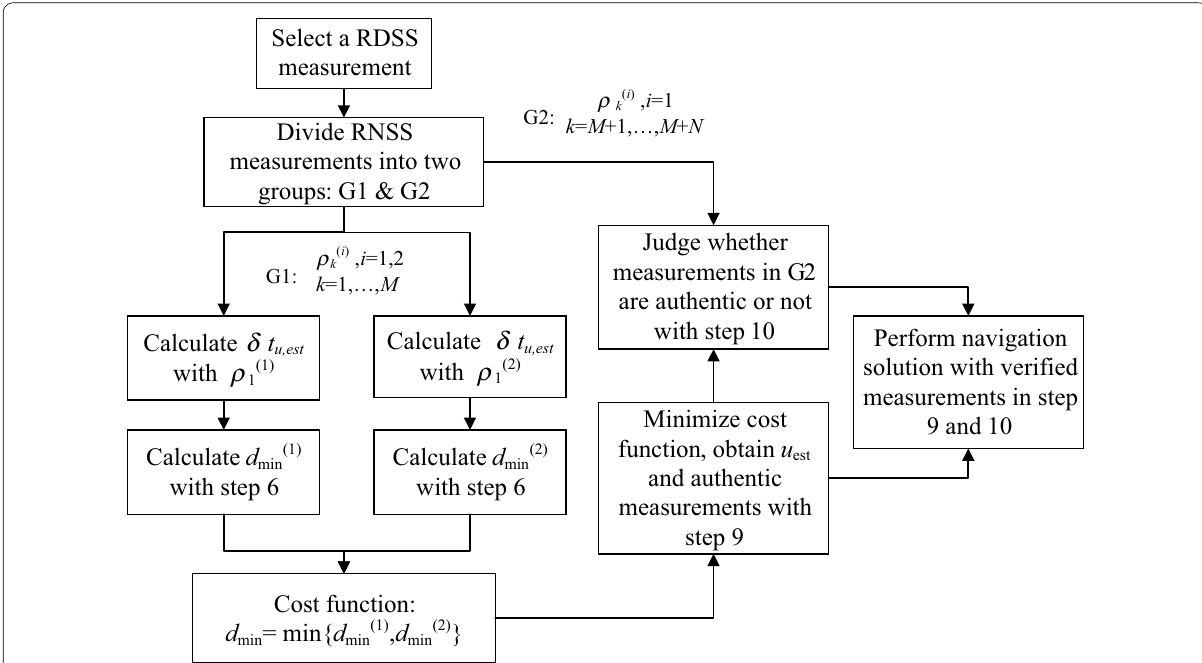
Fig. 4 Diagram of measurements grouping and spoofing mitigation